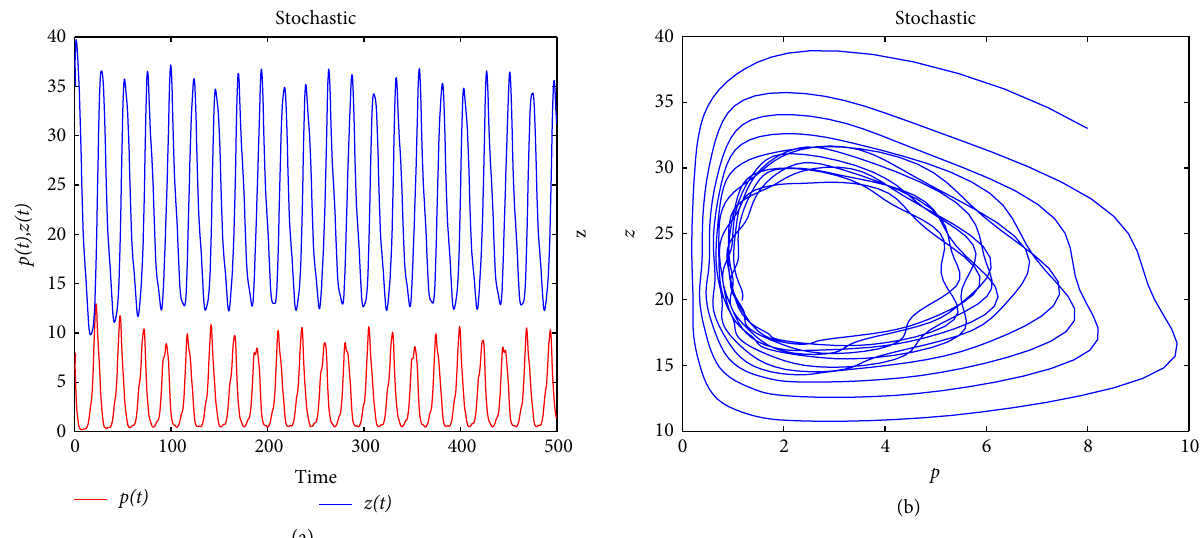
(𝑡) 0.2 0.5 sin 𝑡, 𝜎 (𝑡) 0.12 0.1 sin 𝑡 and 1 2 = + = +